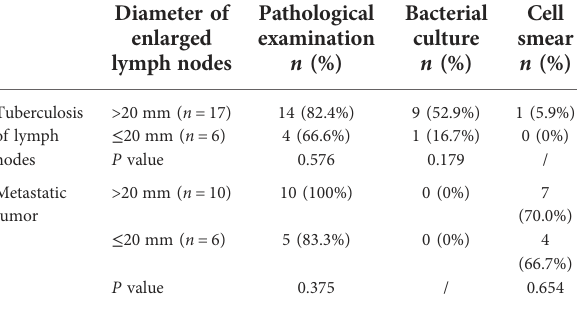
TABLE 5 The positive rates of pathological examination, bacterial culture and cytology of modi fi ed needle aspiration biopsy in lymph nodes with different